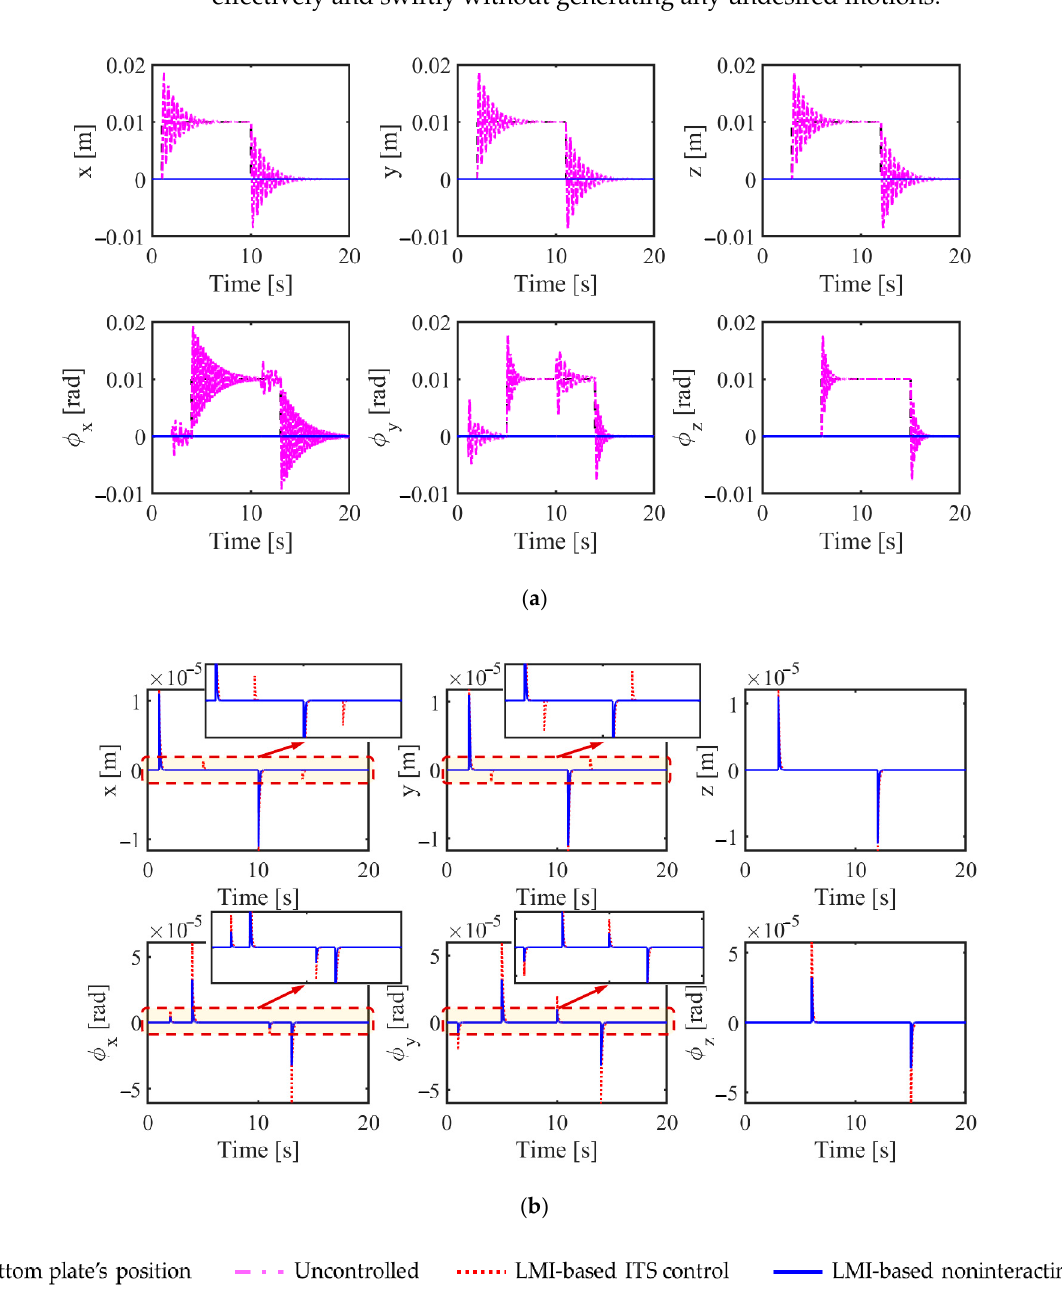
Figure 4. Position of the top plate in the presence of the bottom plate movement. ( a ) The uncontrolled case versus controlled cases; ( b ) Noninteracting control versus ITS control.